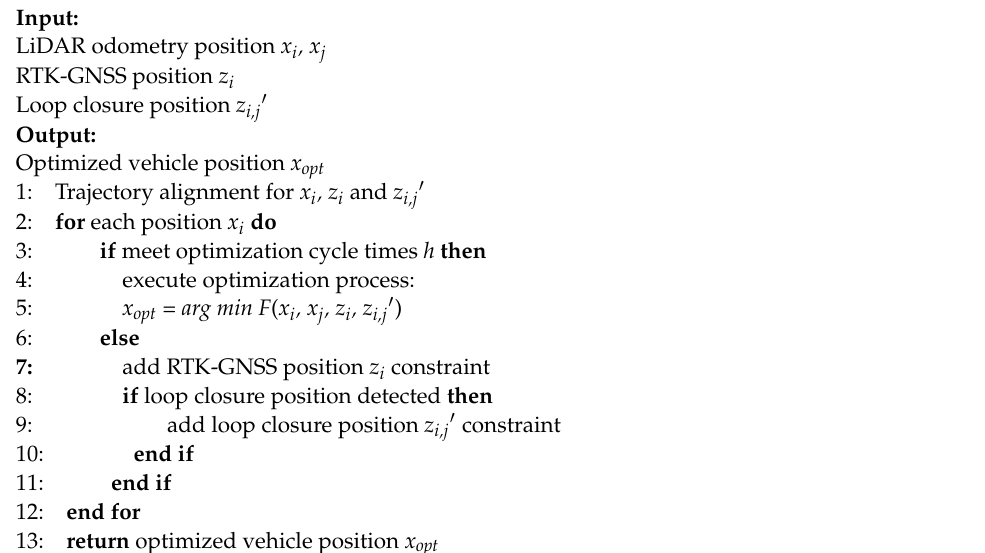
Algorithm 1. The process of back-end optimization